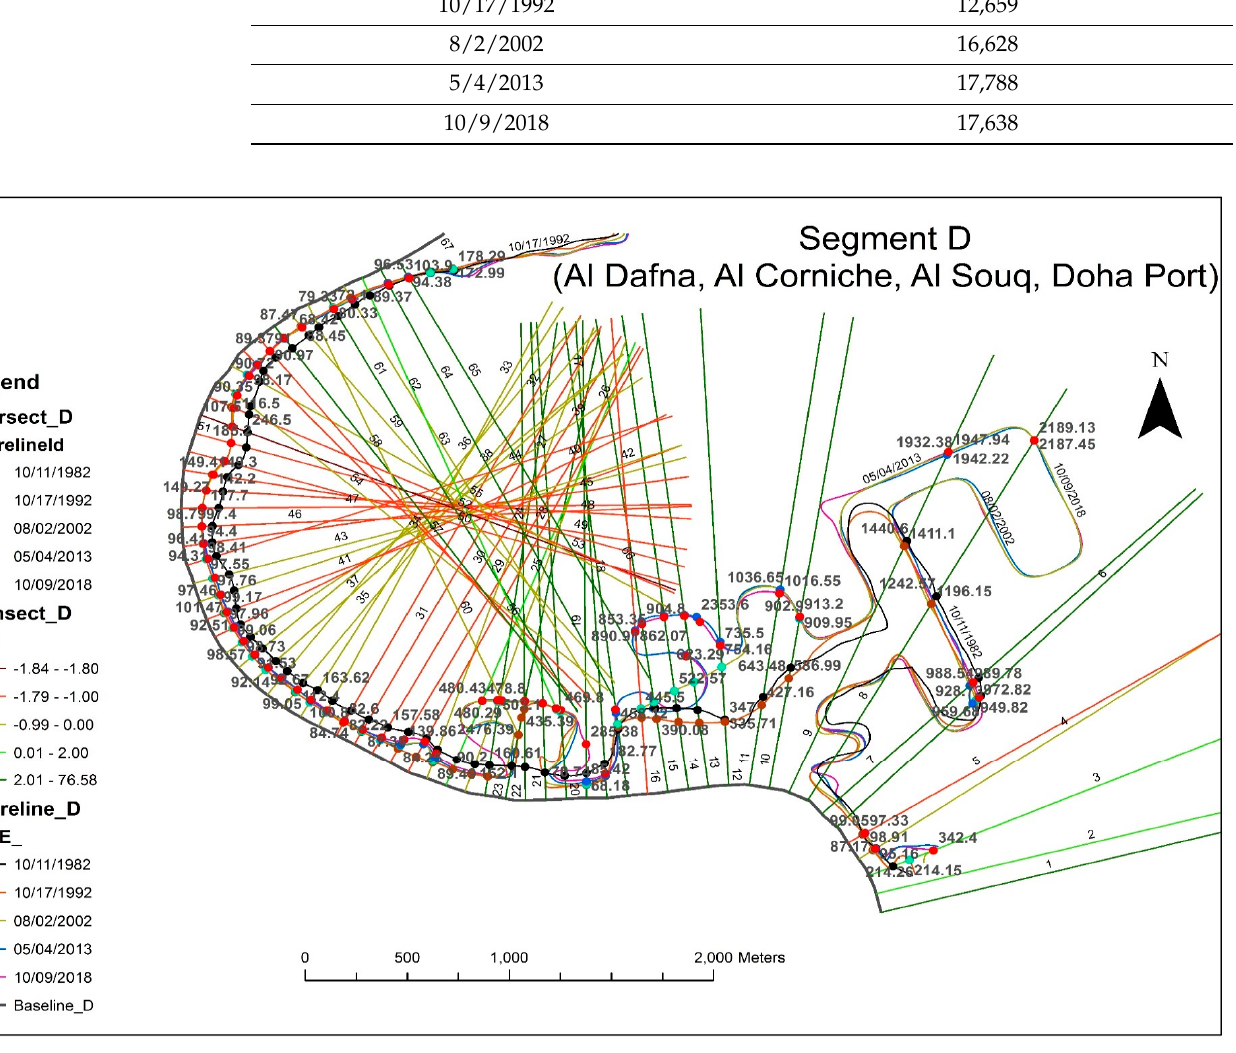
Figure 16. Shoreline of Al Dafna, Al Chorniche, Al Souq, and Doha Port .